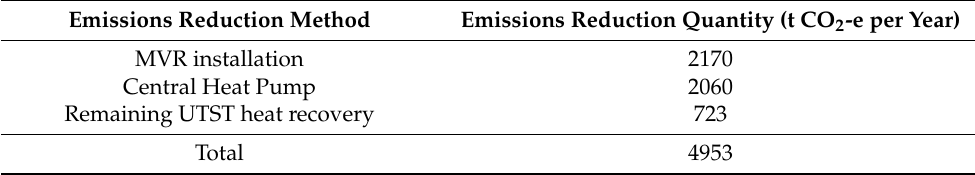
Table 4. Summary of potential emissions reduction from suggested heat pump